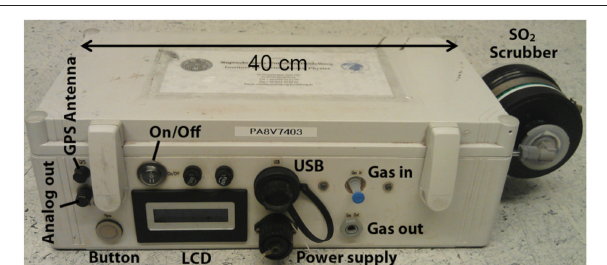
FIGURE 3 | Exterior view of the PITSA instrument. The front panel features: gas in- and outlet, on/off switch for main power (with protective fuses to its right), an LAD screen showing preliminary real time data (SO 2 , CO 2 , temperature and pressure), a programmable push button (typically used to manually trigger zero point measurements) and connectors for USB (real time digital data output, firmware programming), power (battery charging